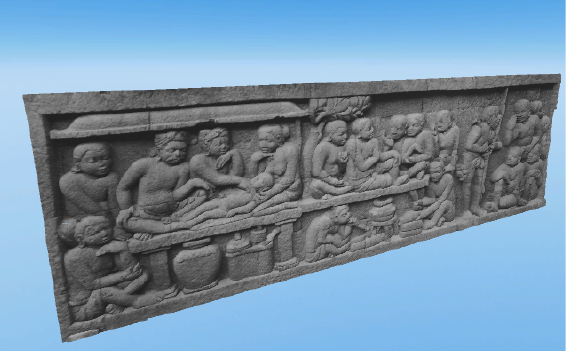
Figure 10. Point cloud of a hidden relief panel reconstructed from a single monocular photo using our (pan et al., 2020) deep learning-based depth estimation